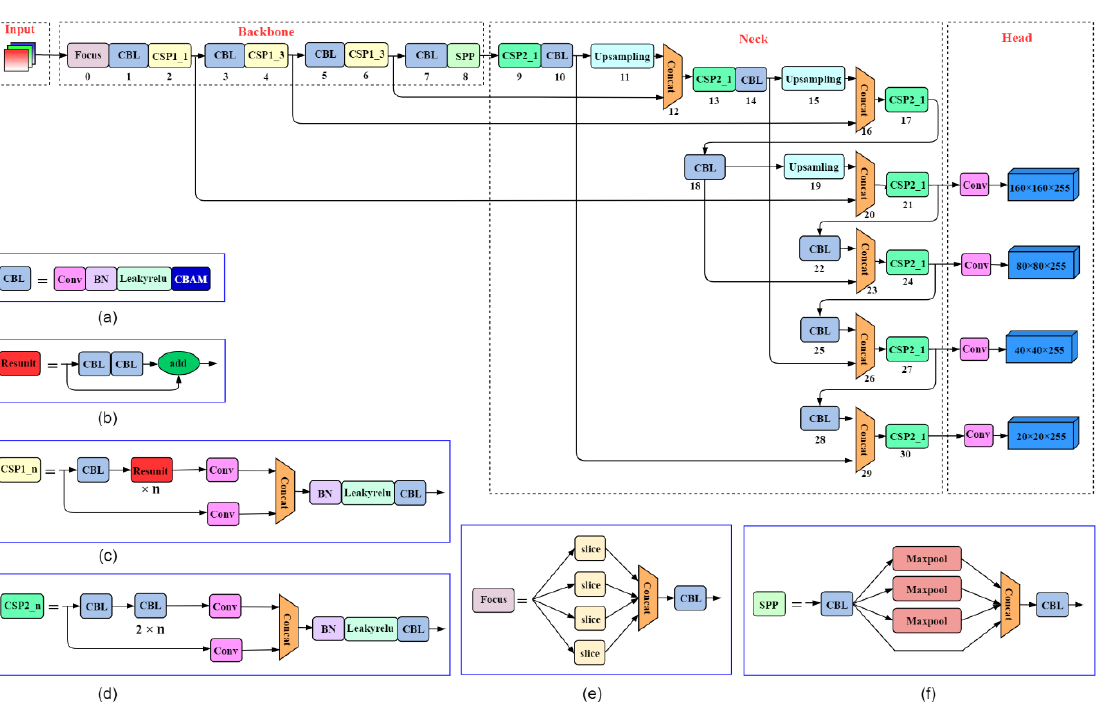
Figure 8. Improved YOLOv5 model: Image ( a ) is the CBL module+CBAM; image ( b ) Resunit borrowing from the residual structure of the Resnet network, the network can be built deeper; image ( c ) CSP1_n, borrowing from the CSPNet network structure, which is composed of CBL module, Resunint module, Conv and Concate, and image ( d ) CSP2_n, borrowing from the CSPNet network structure, which consists of Conv and n Resunint modules [21], Concat; image ( e ) is the Focus structure, which first Concats multiple slice results, and then feeds them into CBL module; image ( f ) uses the maximum pooling method of 1 × 1, 5 × 5, 9 × 9, 13 × 13 to perform multi-scale fusion [22].